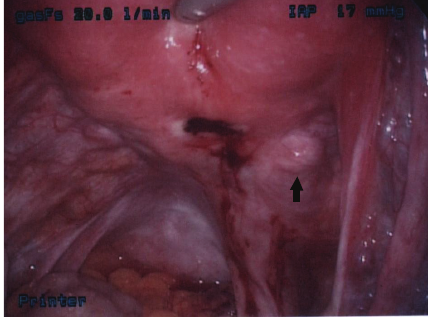
Figure 1: Arrow pointing to IUD within the uterus in a T1 weighted MRI, axial view.